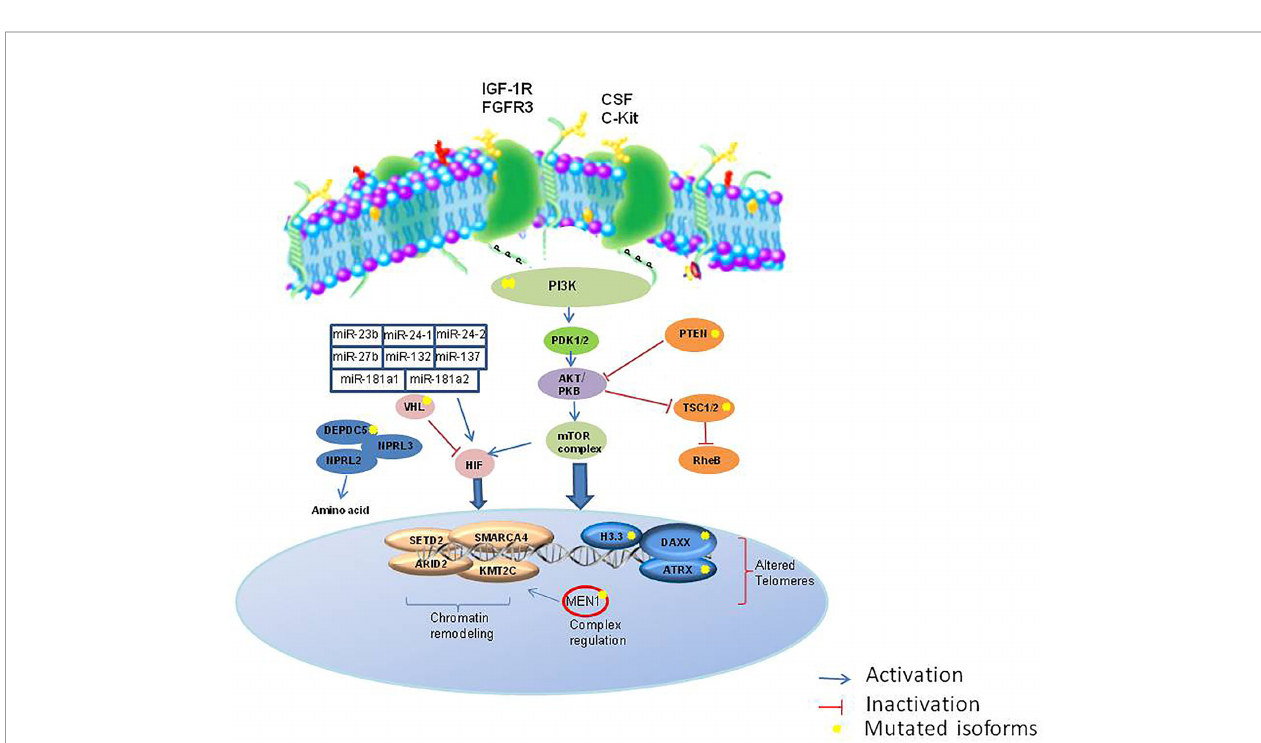
FIGURE 2 | Major epigenetic pathways involved in NETs. IGF1R, insulin growth factor 1 receptor; FGFR, fi broblast growth factor receptor; SCF, colony stimulation factor; c-KIT, c-Kit proto-oncogene; PI3K, phosphatidylinositol 3-kinases; PTEN, Phosphatase and tensin homolog; PDK1/2, protein 3-phosphoinositide-dependent protein kinase-1; TSC1/2, Tuberous sclerosis 1/2; RheB, Ras homolog enriched in brain; HIF, hypoxia factor; RheB, Ras homolog enriched in brain; VHL, Von Hippel-Lindau; DEPDC5, DEP domain containing 5; NPRL3, neuropilin